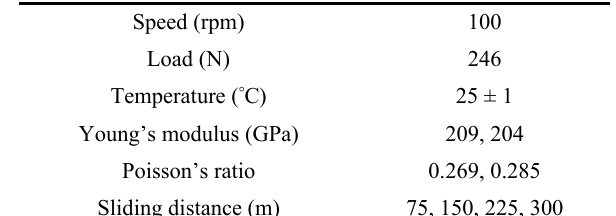
Table 1 Experimental condition.